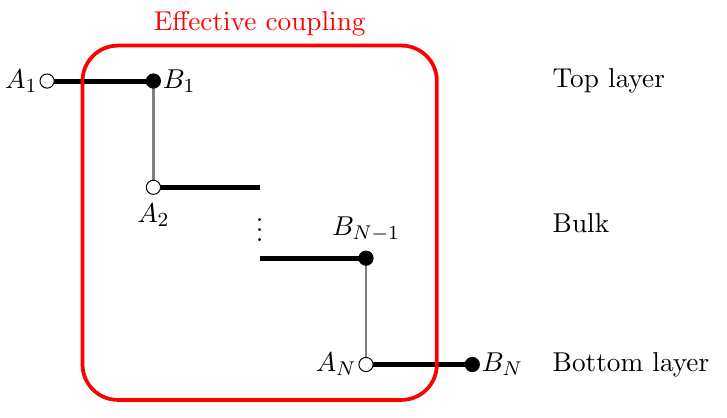
Figure 7 . Semi-effrctive atomic structure of ABC-MLG. The red box is the effective coupling between the top and bottom